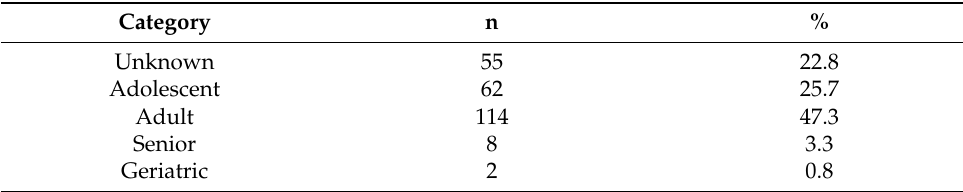
Table 3. Life stages of cats (n = 241) examined for endoparasites.